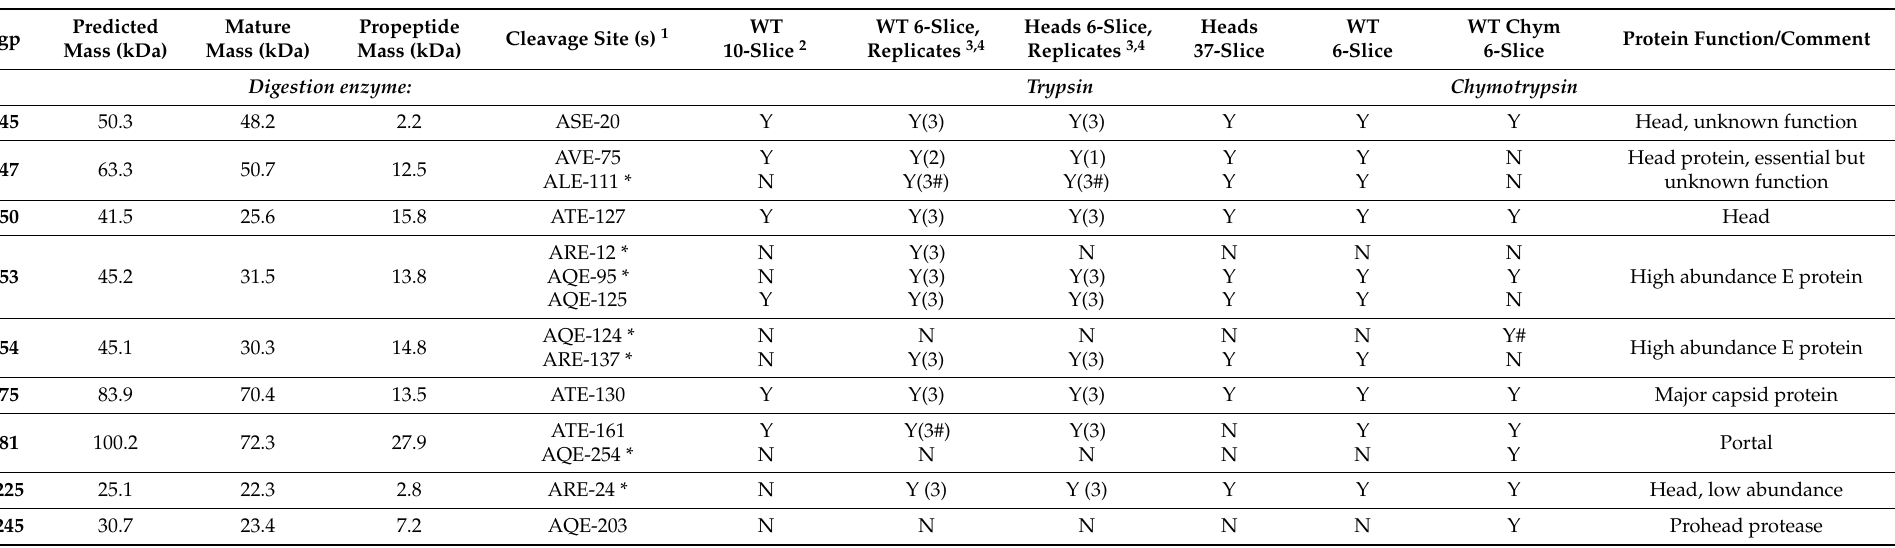
Table 2. Identification of SPN3US head proteins cleaved by the prohead protease gp245 in purified virions and head particles. The identification of a semi-tryptic peptide(s) that supports a gp245 cleavage site in each mass spectral analyses is indicated.